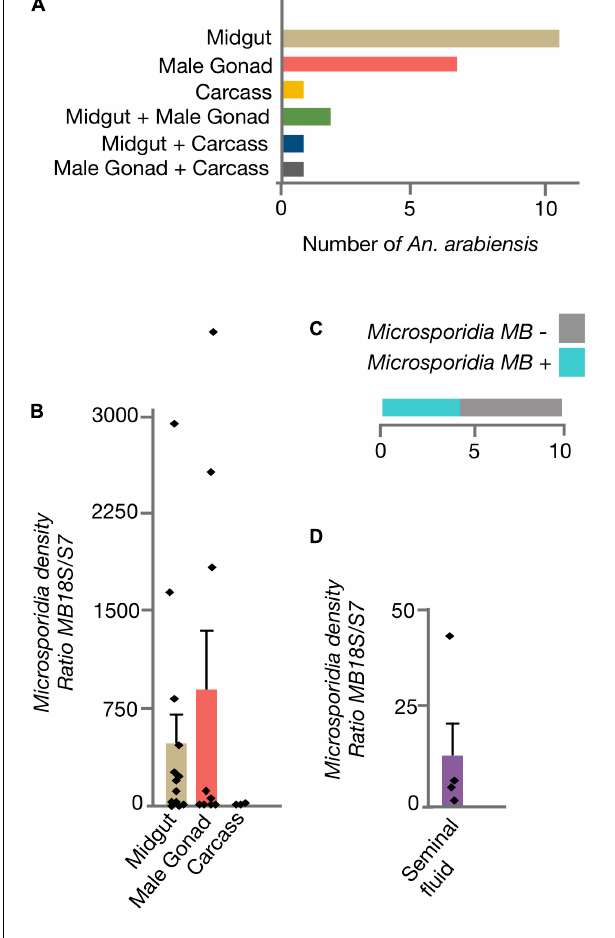
FIGURE 2 | Distribution of Microsporidia MB across male An. arabiensis organs. (A) The screening dissected organs from 22 male An. arabiensis specimens, reveals that Microsporidia MB is detected primarily in the midguts and male gonads. (B) The intensity of Microsporidia MB infection is highest in the midgut and male gonads. (C) The screening male An. arabiensis seminal fluid revealed that Microsporidia MB was detected in 4/10 specimens. (D) The intensity of Microsporidia MB infection in An. arabiensis seminal fluid ranges from a ratio of 0.87 to 41.8 MB18S/S7. Error bars reflect